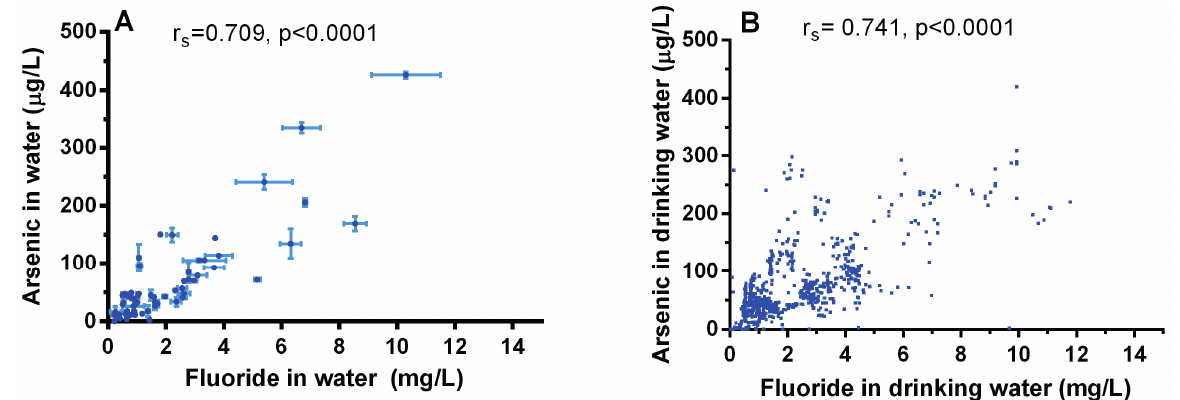
Figure 2. Correlation between arsenic and fluoride levels in drinking water: ( A ) Spearman correlation for water samples obtained from tube wells (3–6 samples per location, bars mean the minimum and maximum concentration of each location, n = 94 locations); and ( B ) from participant’ homes (1 sample per participant, n =